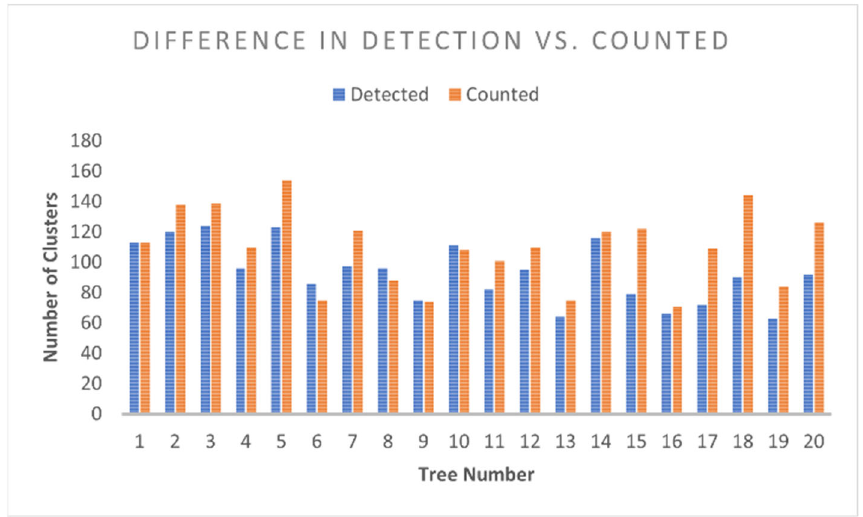
Figure 11. Comparison of the first 20 trees from the ‘right side’ of the row. The percentage error, maximum difference, minimum difference and average differ- ence were calculated for each side of the trees and shown below in Table 2. For the detection of fruit flower clusters on the right side, the percentage error averaged to − 14.52%, which is similar to the result for the left side, which is − 13.49%. The minimum difference and the average difference were also similar between the right and left side with 0 to 1 and 21 to 20. The maximum difference between the detection of the fruit flower clusters and the counted clusters for the right and left side had a difference of 15 clusters, though this does not mean that the maximum difference were obtained from the same